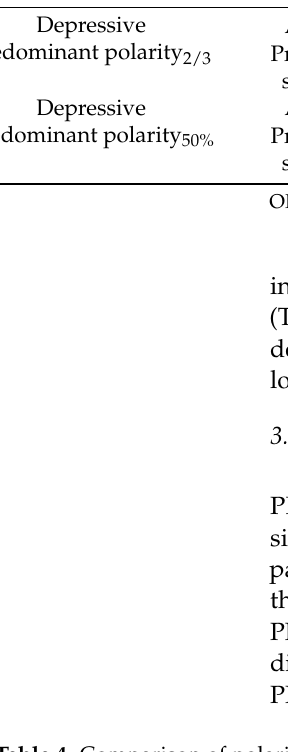
Table 4. Comparison of polarity index values among predominant polarity subgroups defined according to the 50% or 2/3 of prevalent episodes